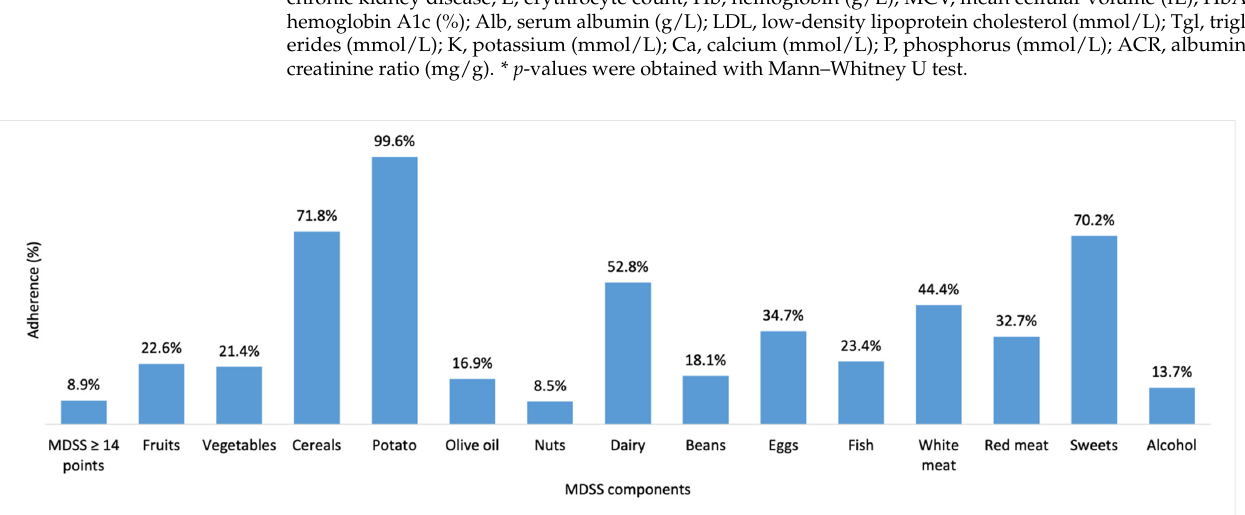
Figure 3. Adherence to the MeDi and its components regarding the presence of CKD. Abbreviations: CKD, participants with chronic kidney disease; non CKD, participants without chronic kidney dis- ease; MDSS, Mediterranean Diet Serving Score p -values were obtained with chi-square test ( p < 0.05). When adjusted for age, gender, BMI, and eGFR statistically significant associations between blood pressure parameters, body composition, and anthropometric parameters